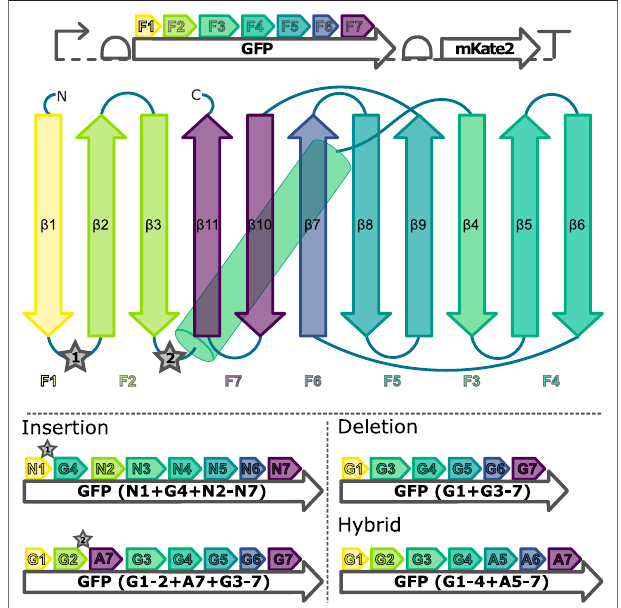
FIGURE 2 | Genetic construct and secondary structure indicating the fragments used for assemblies of the GFP proteins. Top: Bicistronic operon structure encoding the engineering target GFP and the assembly-control reporter mKate2. Middle: Schematic depicting the F1-F7 GFP DNA fragments used for the family shuf fl ing. mKate2: red fl uorescent protein; β 1- 11: β -sheets of the GFPs; + 1 and 2: insertion sites for additional β -sheets. Bottom: Examples for the three fragment recombination strategies performed including their nomenclature. G n : sfGFP fragment n ; A n : mAvicFP1 fragment n ; N n : mNeonGreen fragment n